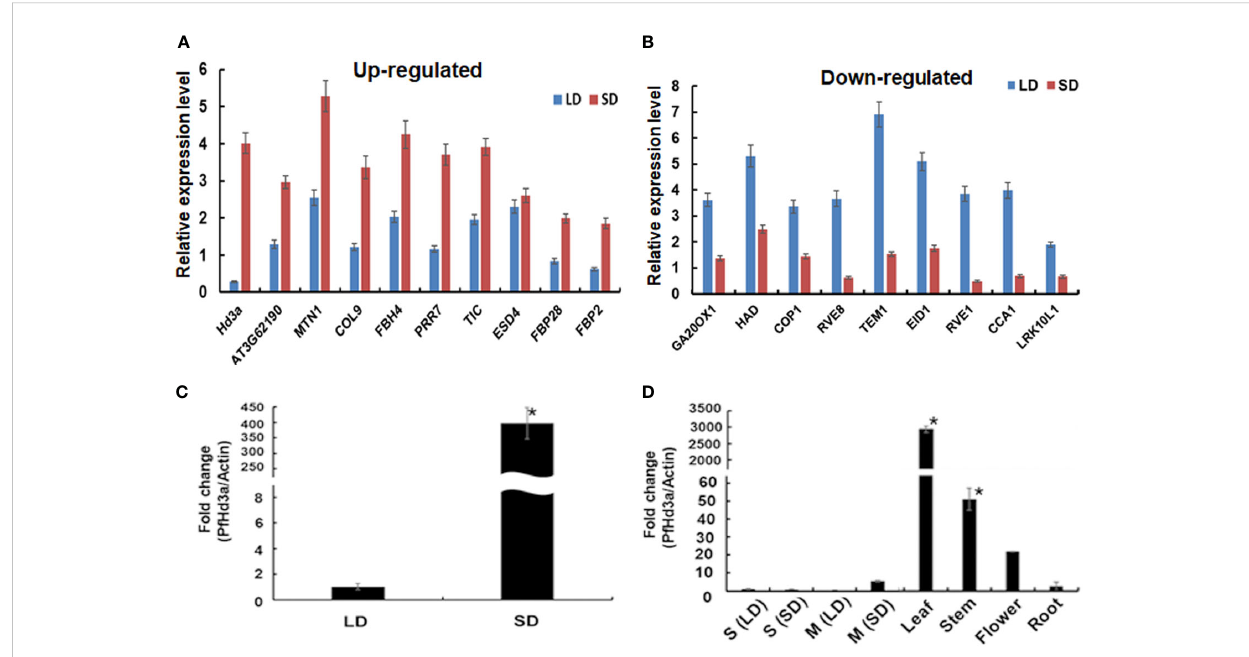
FIGURE 1 Transcript level of fl owering related genes in perilla. (A) Transcript level of up-regulated and (B) down-regulated perilla fl owering related genes under SD sample compared with LD sample. De novo RNA sequencing data were analyzed and transcript levels were compared between LD and SD sample. Average and error bar values were calculated with normalized read counts of two biological samples. Statistical signi fi cance was determined by Student ’ s test (*P < 0.05). (C) Quantitative transcript levels of PfHd3a gene under SD. Transcript levels of PfHd3a was compared by qRT-PCR between LD and SD. Statistical signi fi cance was determined by Student ’ s test (*P < 0.05). (D) PfHd3a expression in 2-week-old seedling (S), mature (M) perilla and various organs from one-month mature plants under SD condition as determined by qRT-PCR. LD: 16 h light/8 h dark. SD:8 h light/16 h dark. Statistical signi fi cance was determined by Student ’ s test (*P <